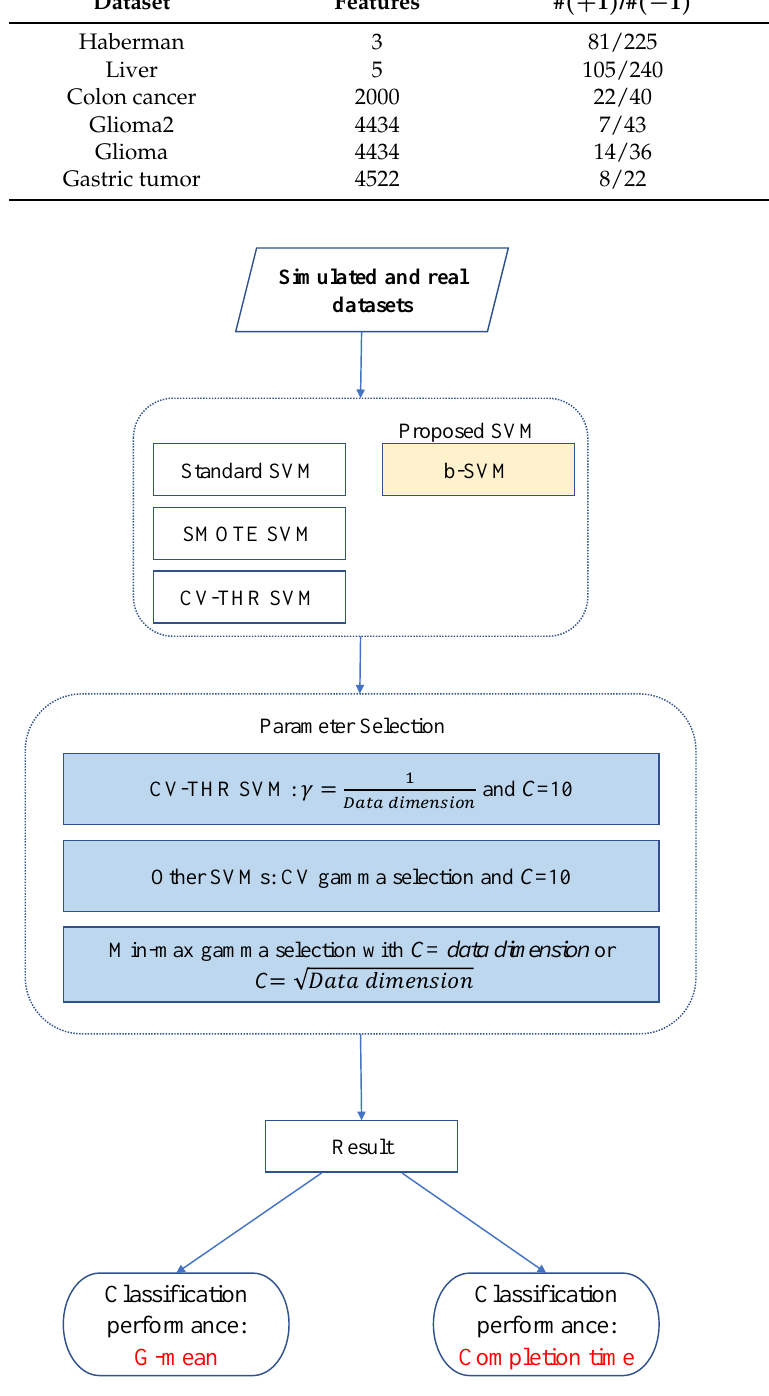
Figure 1. The flow chart of experimental design and analysis: parameter selection for imbal- anced